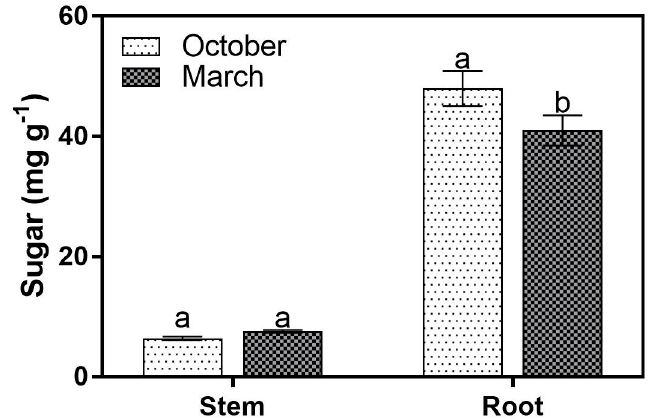
Figure 2. Mean ( ± SE) sugar concentrations (mg g − 1 ) for organ (stem and root) by month (October and March) averaged across species (PT = Pinus tadea , PE = Pinus elliottii , and PP = Pinus palustris ). Bars with different letters within an organ indicate significant difference ( α = 0.05).